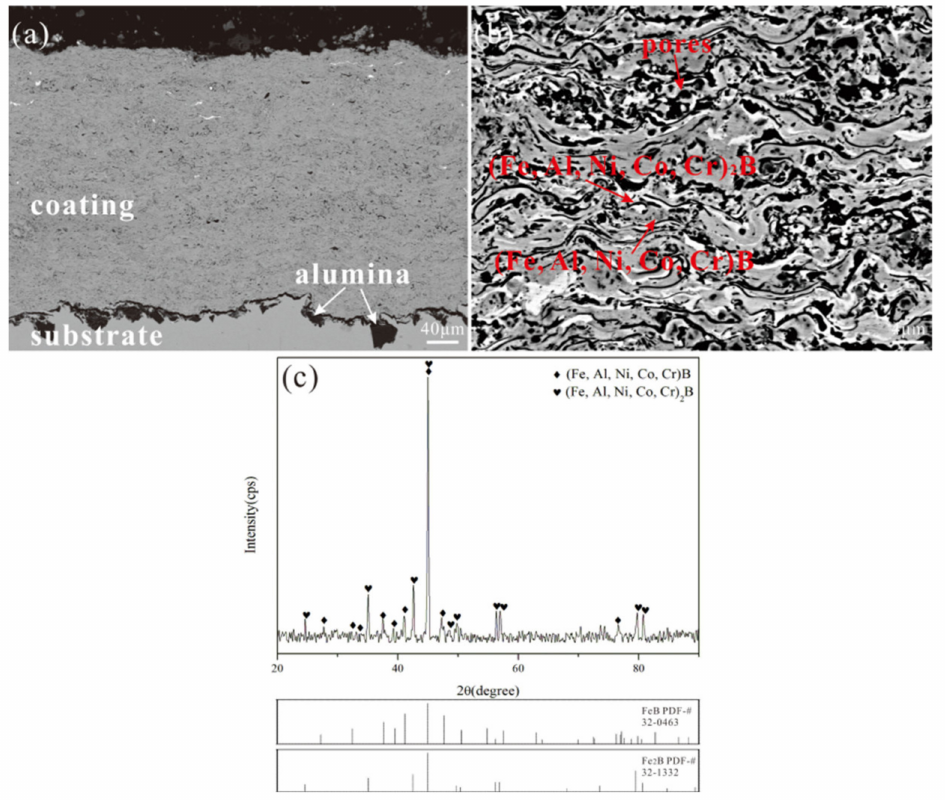
Figure 4. Morphologies and phase compositions of FeB-30 wt.% Al 0.25 FeNiCoCr coating after ball milling and vacuum sintering: ( a ) ball milling, ( b ) vacuum sintering, and ( c ) phase